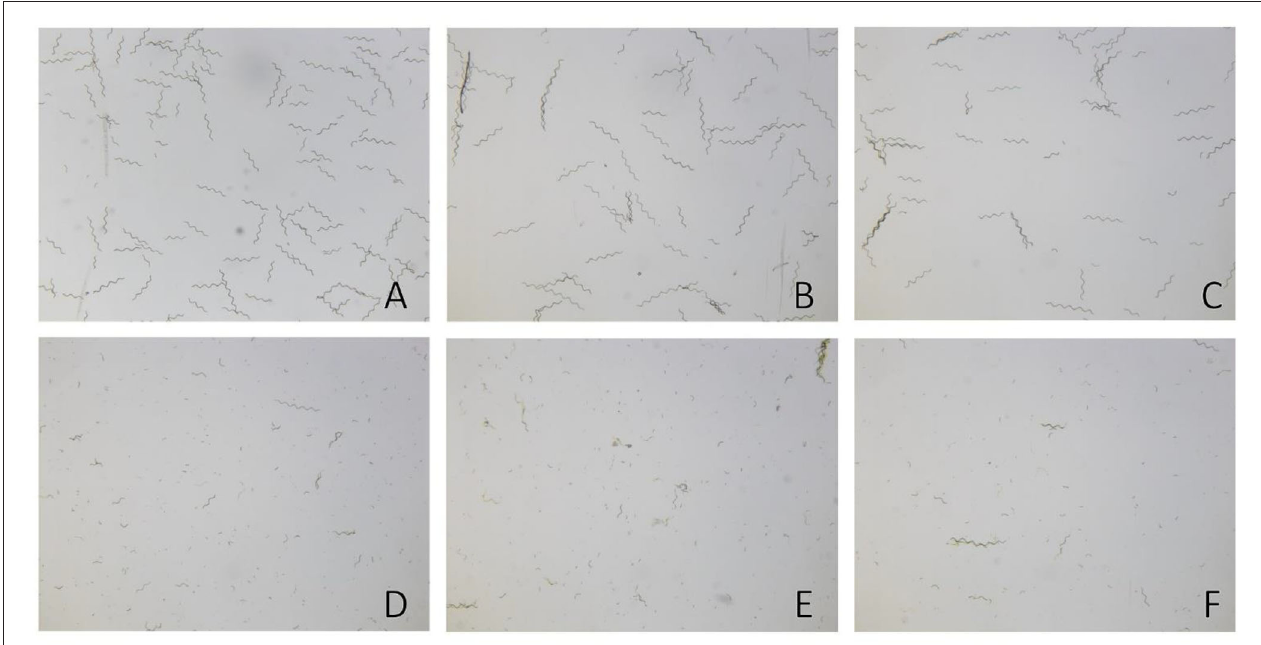
FIGURE 5 | Decay of Arthrospira platensis trichomes over time after pulsed electric field (PEF) treatment, shown for the treatment at 10 kV cm − 1 and 45 ◦ C as an example. (A) Untreated cells. (B) PEF-treated cells after 0min. (C) PEF-treated cells after 30min. (D) PEF-treated cells after 60min. (E) PEF-treated cells after 120min. (F) PEF-treated cells after 180min of